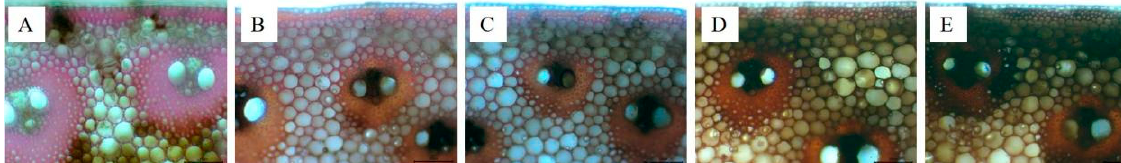
Figure 8. Infection the internode cortex after the inoculation of Pythium aristosporum (Dika517, 2018). ( A – E ) indicate the 20th day, 30th day, 40th day, 50th day, and the 60th day after inoculation, respectively.